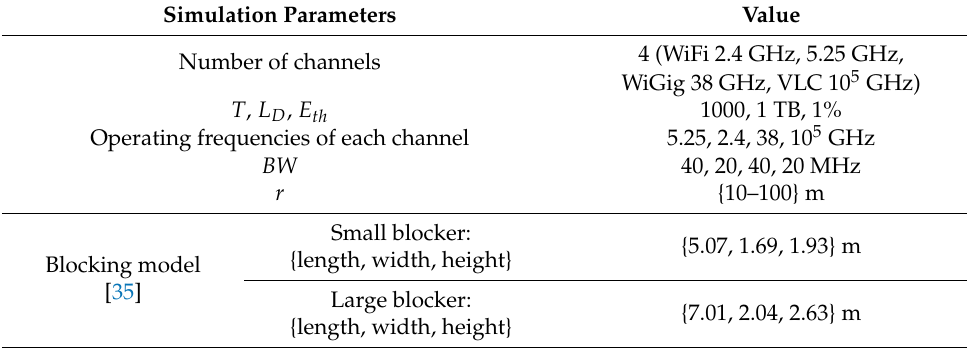
Table 1. Simulation